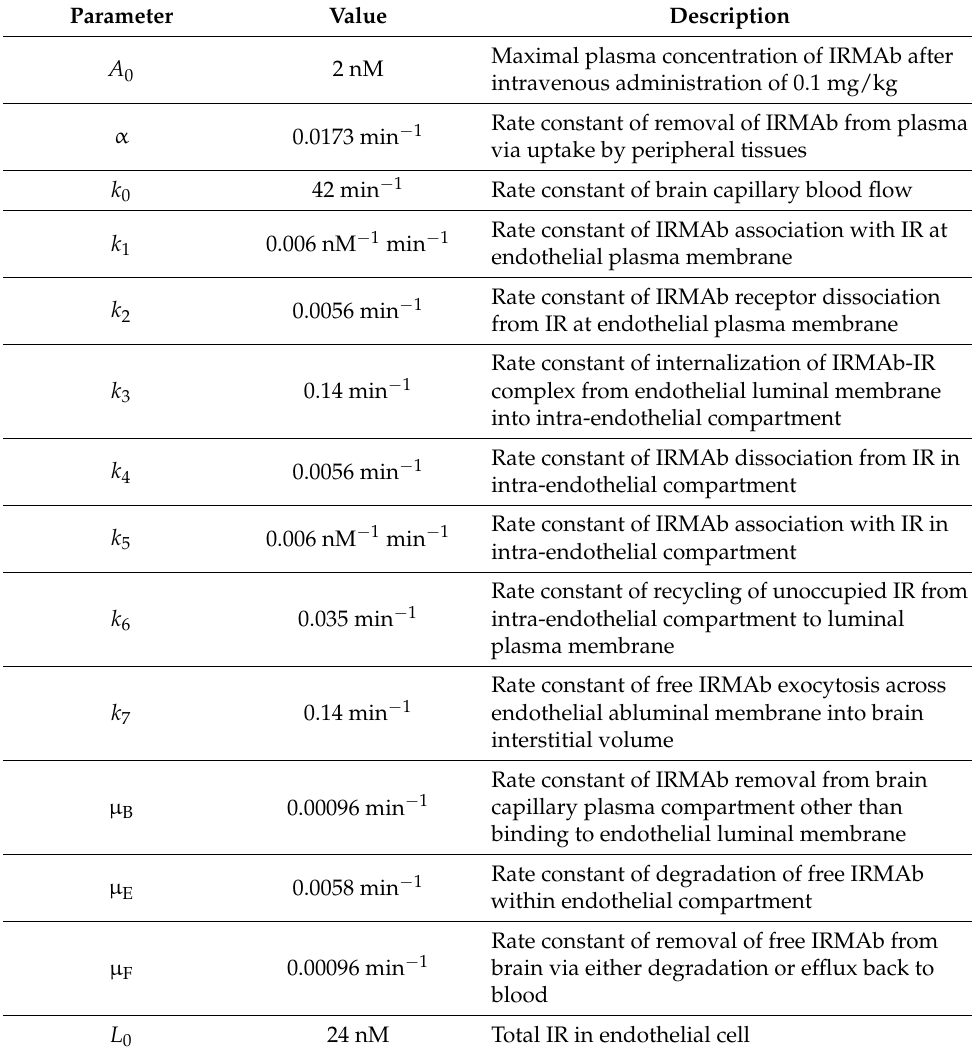
Table 7. Parameter definitions and starting values for IR